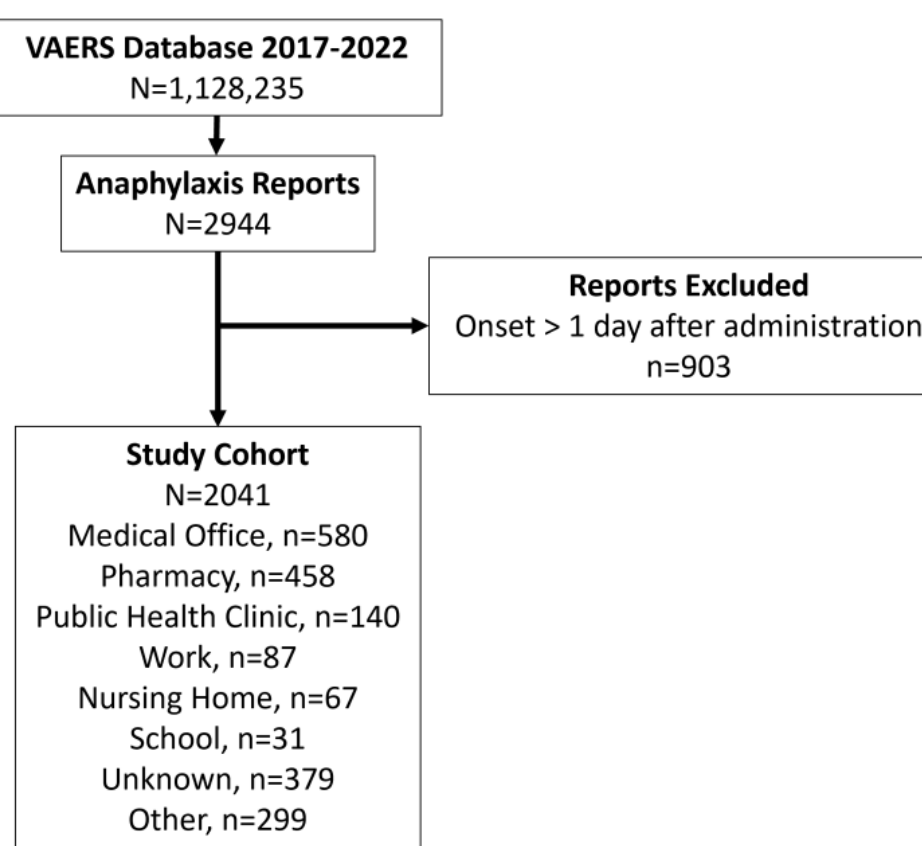
Table 1. Demographics and Outcomes of Post-Vaccination Anaphylaxis Reports by Administration